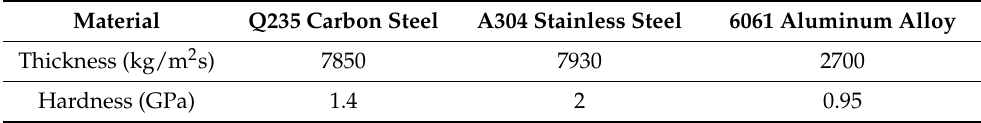
Table 1. Characteristic parameters of the specimen